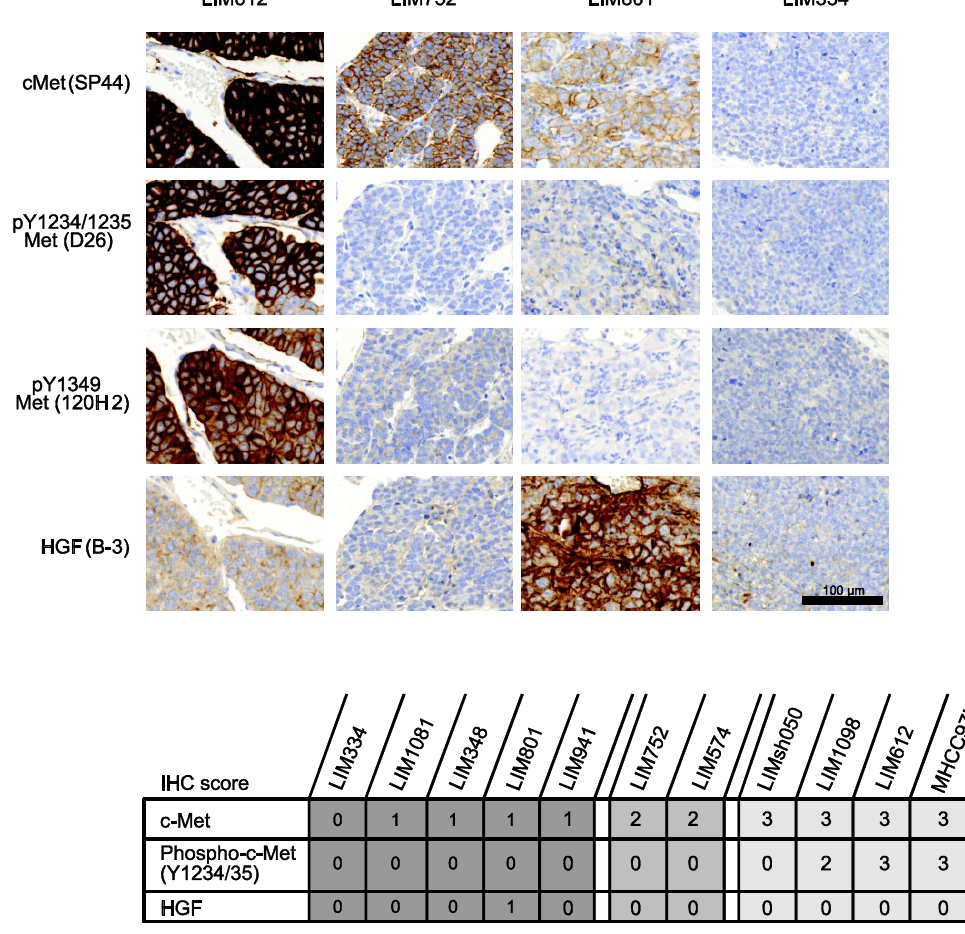
Figure 2. Expression of c-Met, HGF, and phospho-c-Met in patient-derived HCC